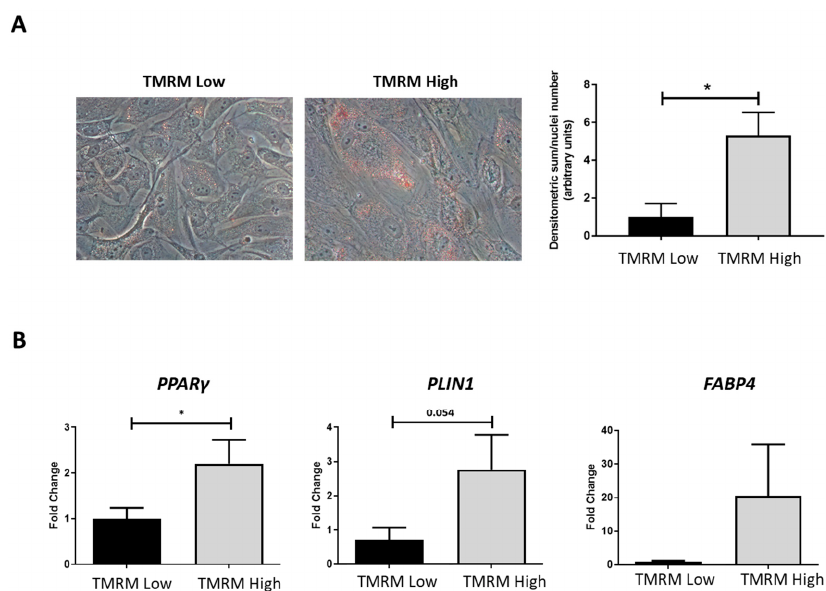
Figure 8. In vitro adipogenic di ff erentiation of TMRM-low and high cells. ( A ) The culture in pro-adipogenic conditions for 1 week favored morphological di ff erentiation in particular of TMRM-high cells, as evidenced by accumulation of lipid droplets in the cytoplasm, stained by Oil-Red-O (left panels). The bar graph shows the relative quantification (right panel). ( B ) Expression of the pro-adipogenic genes PPAR γ : peroxisome proliferator-activated receptor gamma, PLIN1 : perilipin 1, and FABP4 : fatty acid-binding protein 4. Data are represented as mean ± SD of the fold change. n = 4 per group. Statistical differences were calculated significant as * p < 0.05, determined by Student’s t-test.